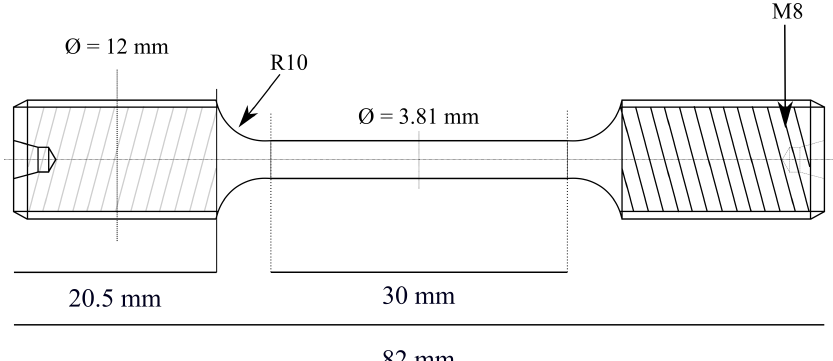
Figure 2. Schematic drawing of the round tensile specimens used for slow strain rate